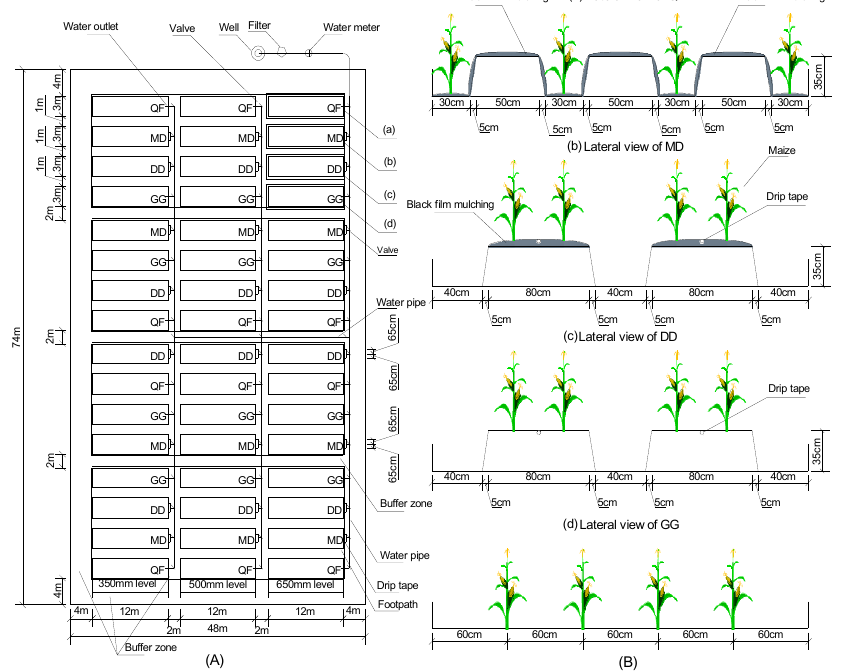
Figure 2. Schematic diagrams for field experimental plot layout showing four replicated blocks, and four randomly assigned treatments. Plot size: Width 3 m (4 rows at 0.8 m spacing in QF, and at 0.6 m spacing in MD, DD, and GG). ( A ) represents schematic diagrams of the test field. ( B ) represents profile diagram of treatments. Length 12 m. Total area (36 m 2 ); 1m buffers among plots, 4 m buffers between crops and on field edges.